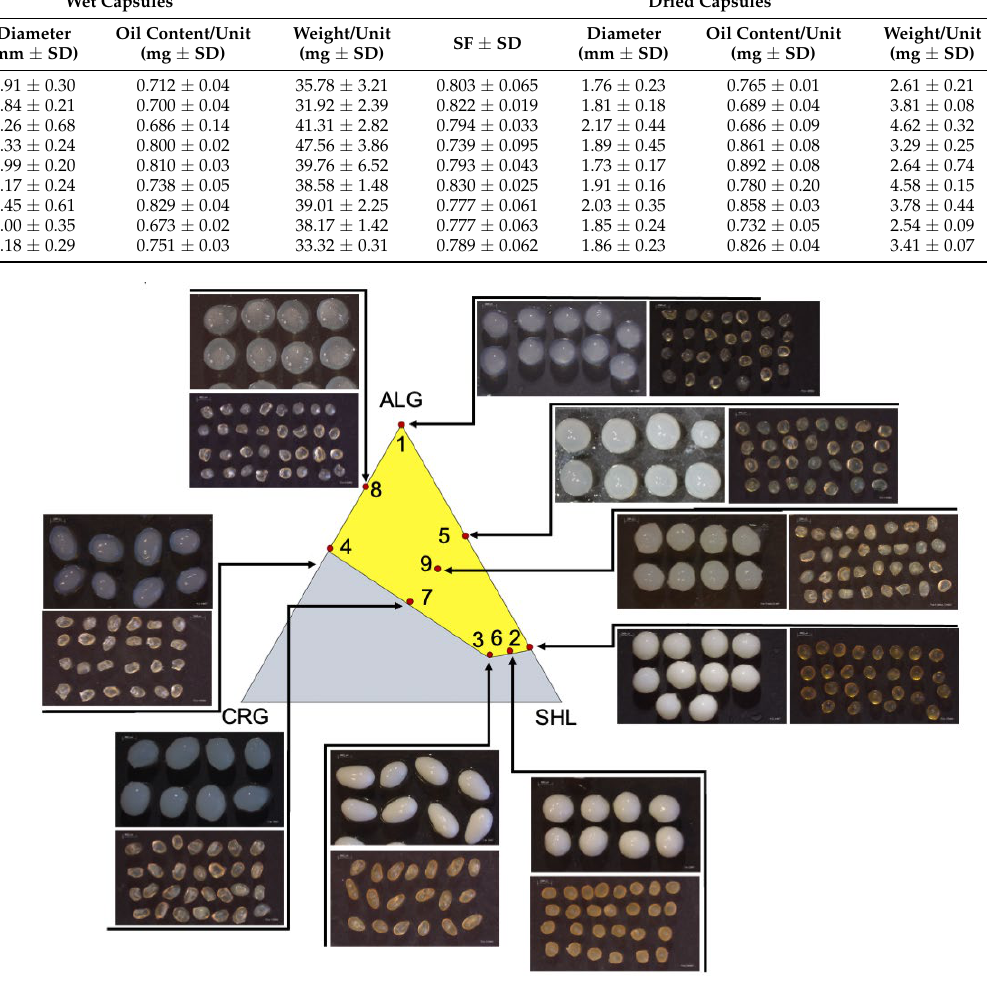
Figure 2. Experimental points and corresponding wet and dried core–shell systems.